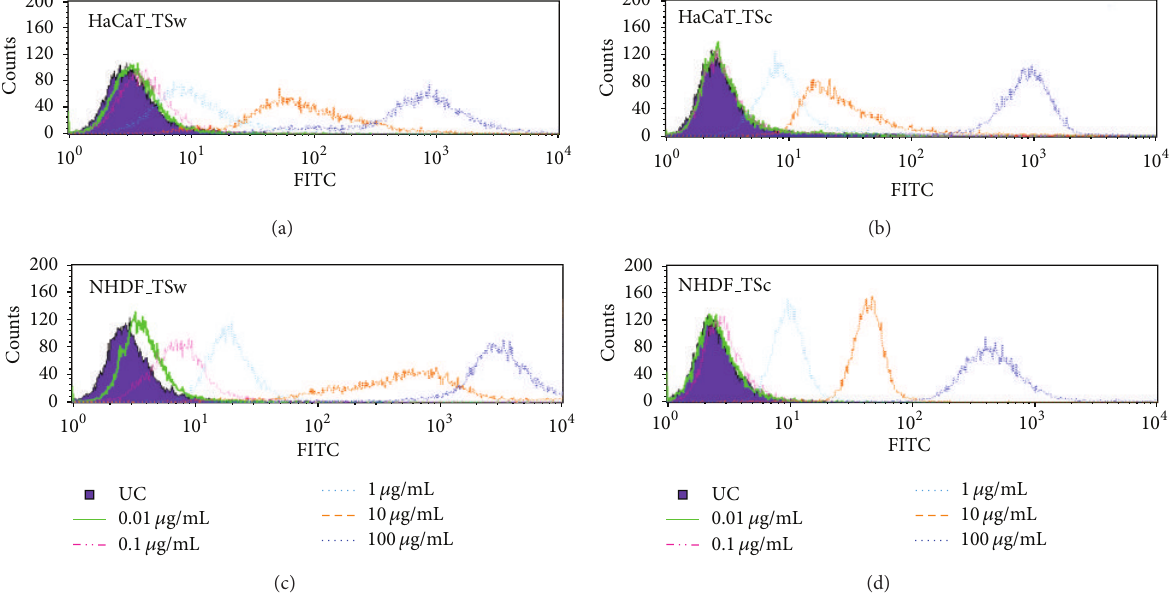
Figure 7: Fluorescence intensity of FITC-TSw ((a) and (c)) and FITC-TSc ((b) and (d)) applied to HaCaT ((a) and (b)) and NHDF ((c) and (d)) in concentrations of 0.01 𝜇 g/mL–100 𝜇 g/mL. Incubation took place for